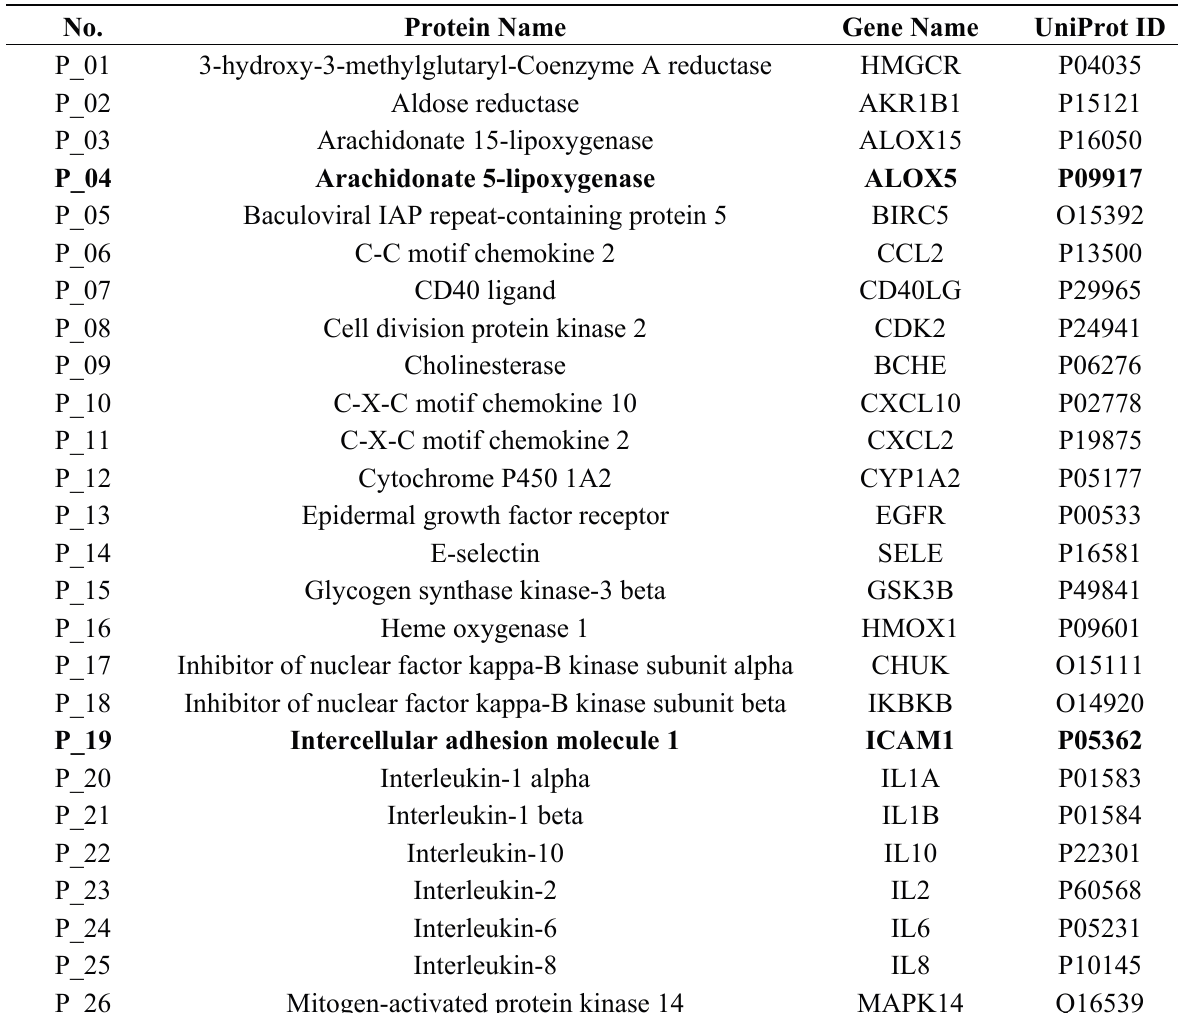
Table 2. The information of anti-inflammation-related targets of Folium Eriobotryae.